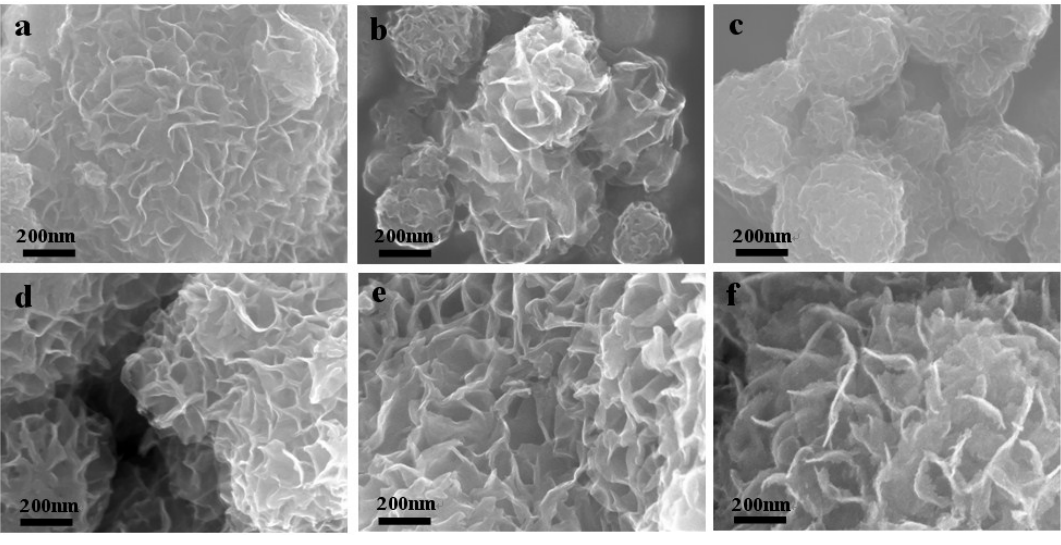
Figure 5. SEM images ( a – f ) of the MoS 2 /polymer composites synthesized at various concentrations, where a – f represent MoS 2 /PVP–0.08, MoS 2 /PVP–0.4, MoS 2 /PVP–2.0, MoS 2 /PEI–0.04, MoS 2 /PEI–0.2, and MoS 2 /PEI–0.4